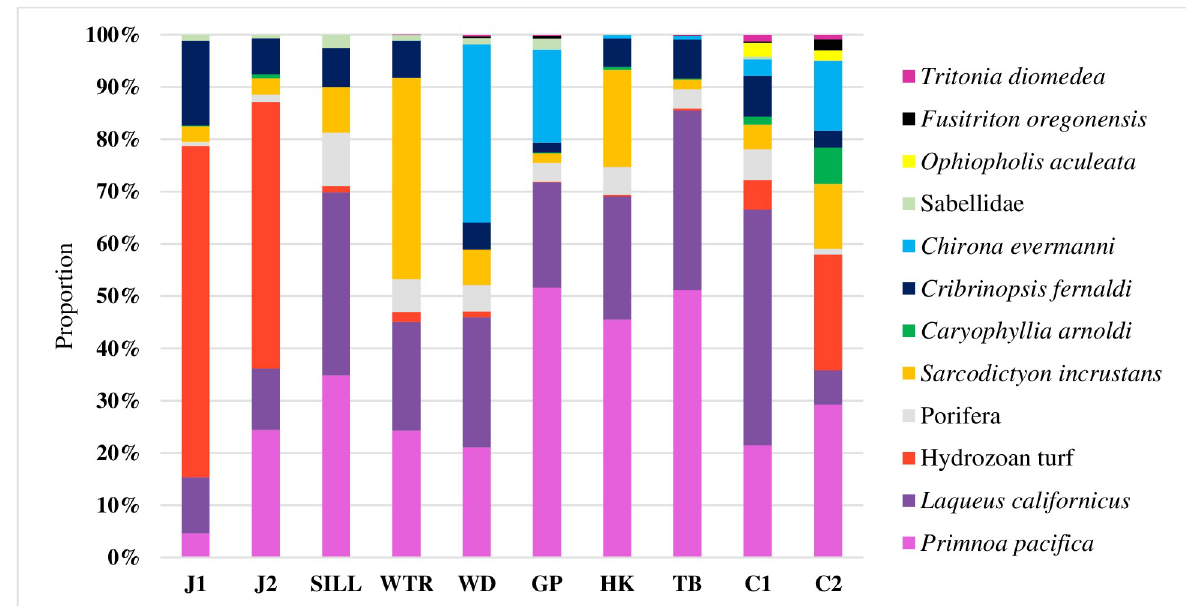
Fig 4. Species dominance based on proportion at each site. The sites in this graph are organized by proximity to glacial input (site J1 is closest to a tidewater glacier and site C2 is the furthest).